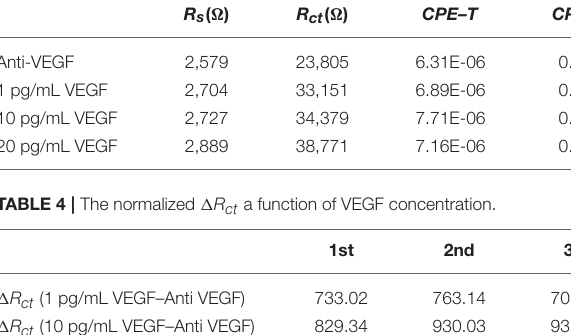
TABLE 3 | The fitted result of the impedance spectra in Figure 4e obtained from ZView software. R s ( (cid:127) )